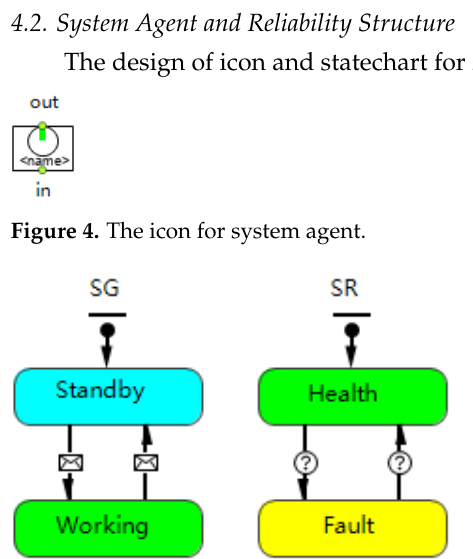
Figure 5. The statechart for system agent.